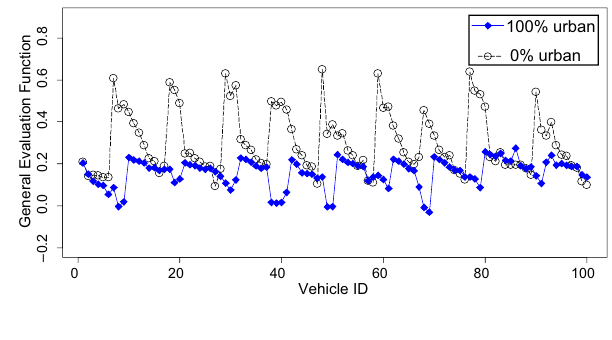
Figure 8 GEF of connected vehicles in the urban intersection